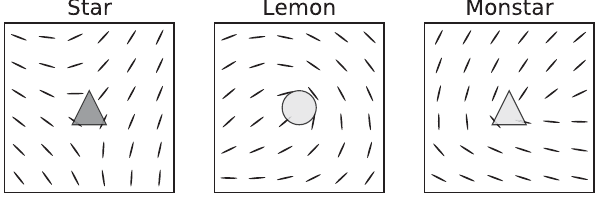
FIG. 3. An overview of the three kinds of C points based on their line classification [43]. The lines are the orientation of the polarization ellipse at each pixel around the C point (circle or triangle), as determined from experimental